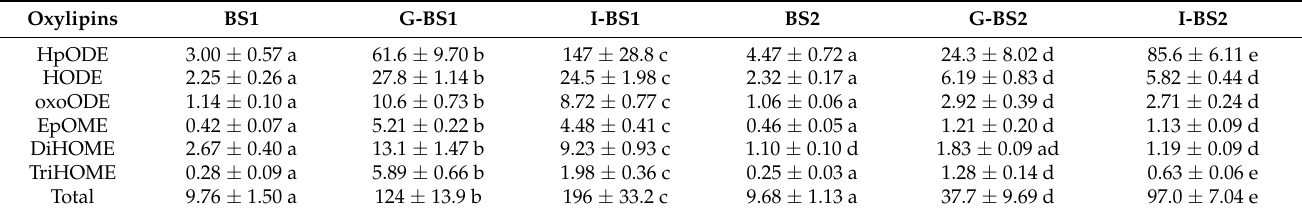
Table 2. Abundances of different classes of oxylipins in black seed oil (BS1 and BS2) and lipid extracts of the digestates after gastric (G-BS1 and G-BS2) and intestinal (I-BS1 and I-BS2) in vitro digestion, expressed as the area under the peak of the corresponding MRM